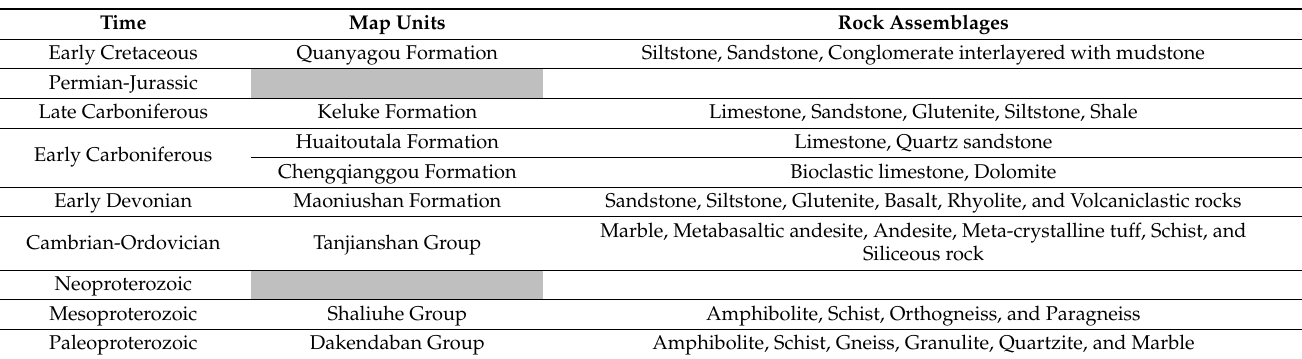
Table 1. Paleoproterozoic – Mesozoic stratigraphic sequence for the Nankeke area in the NQ.